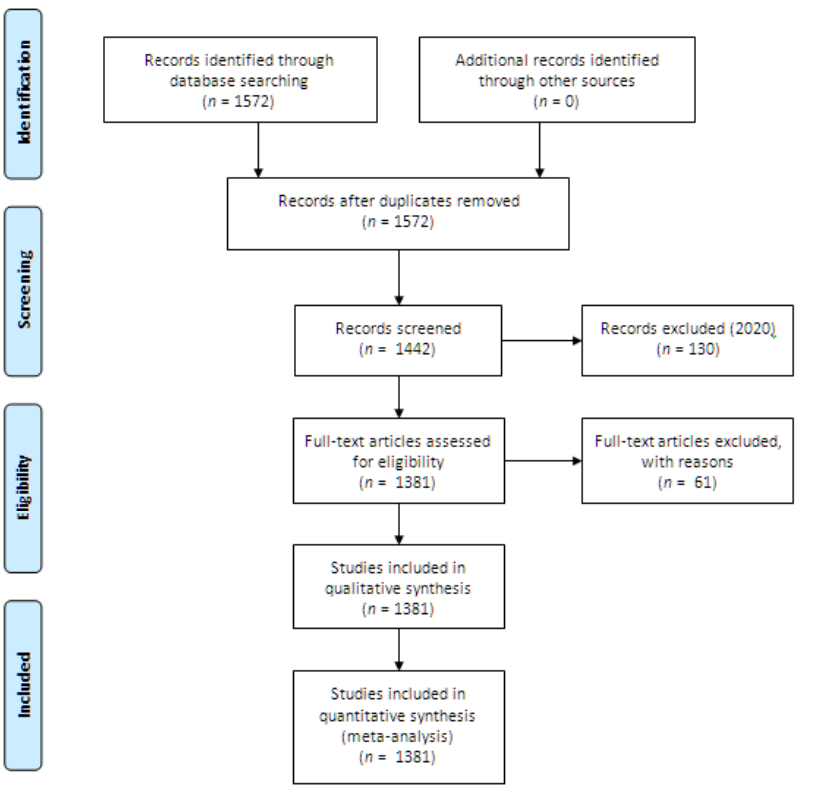
Figure 1. Flowchart according to the PRISMA Declaration.